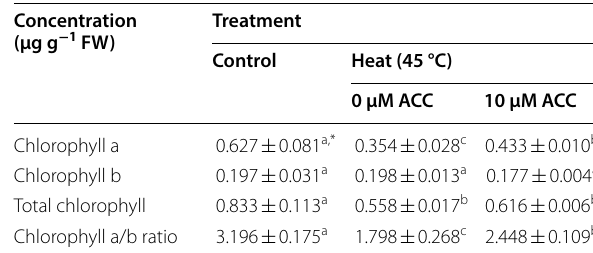
Table 1 Chlorophyll concentration of rice seedlings under heat stress combined with ACC treatment